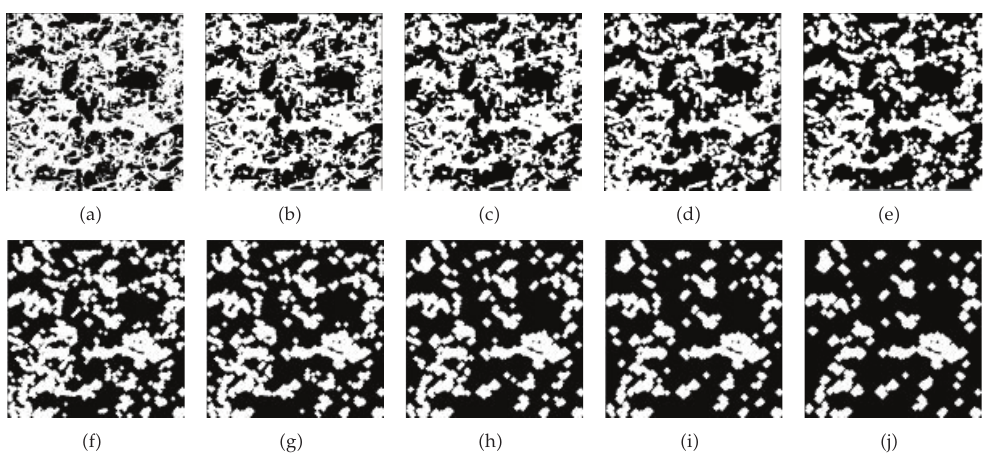
Figure 3: (cid:2) a–j (cid:3) A sequence of multiscale pore generated via opening transformations by a symmetric